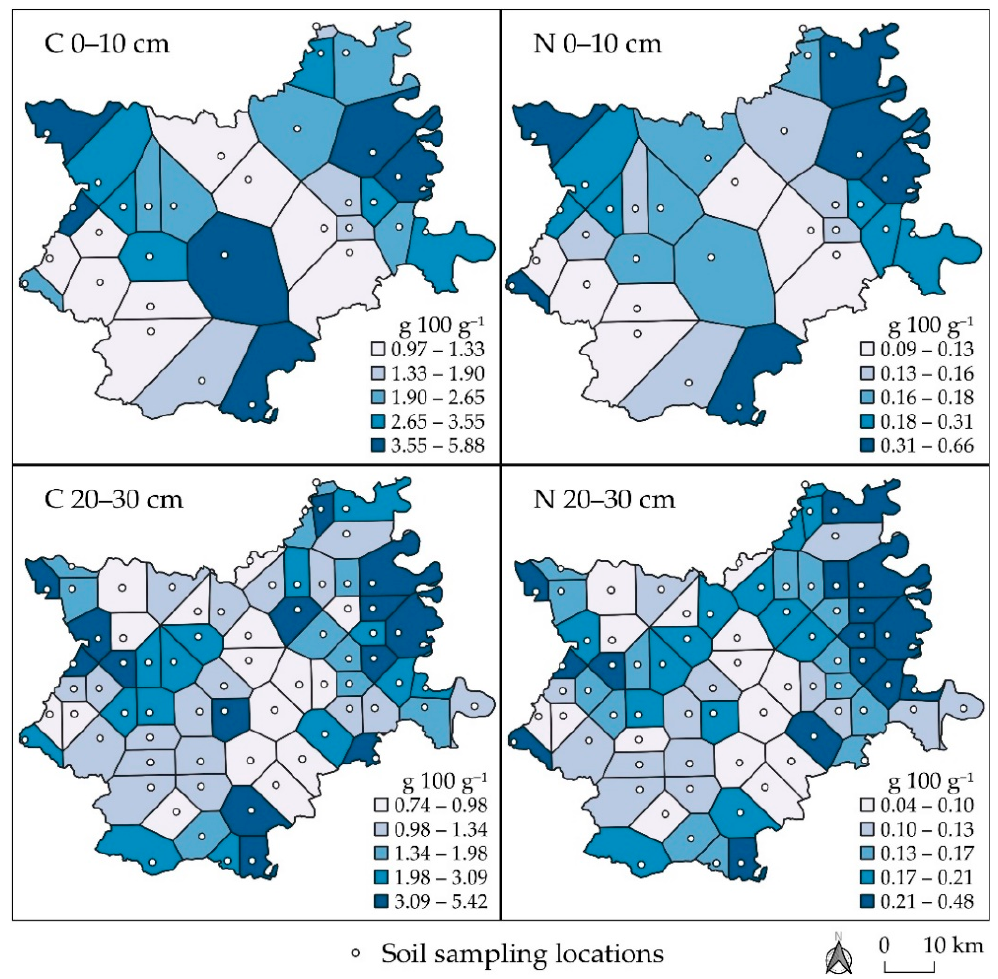
Figure 3. Thiessen polygons for the stationarity evaluation of input samples.